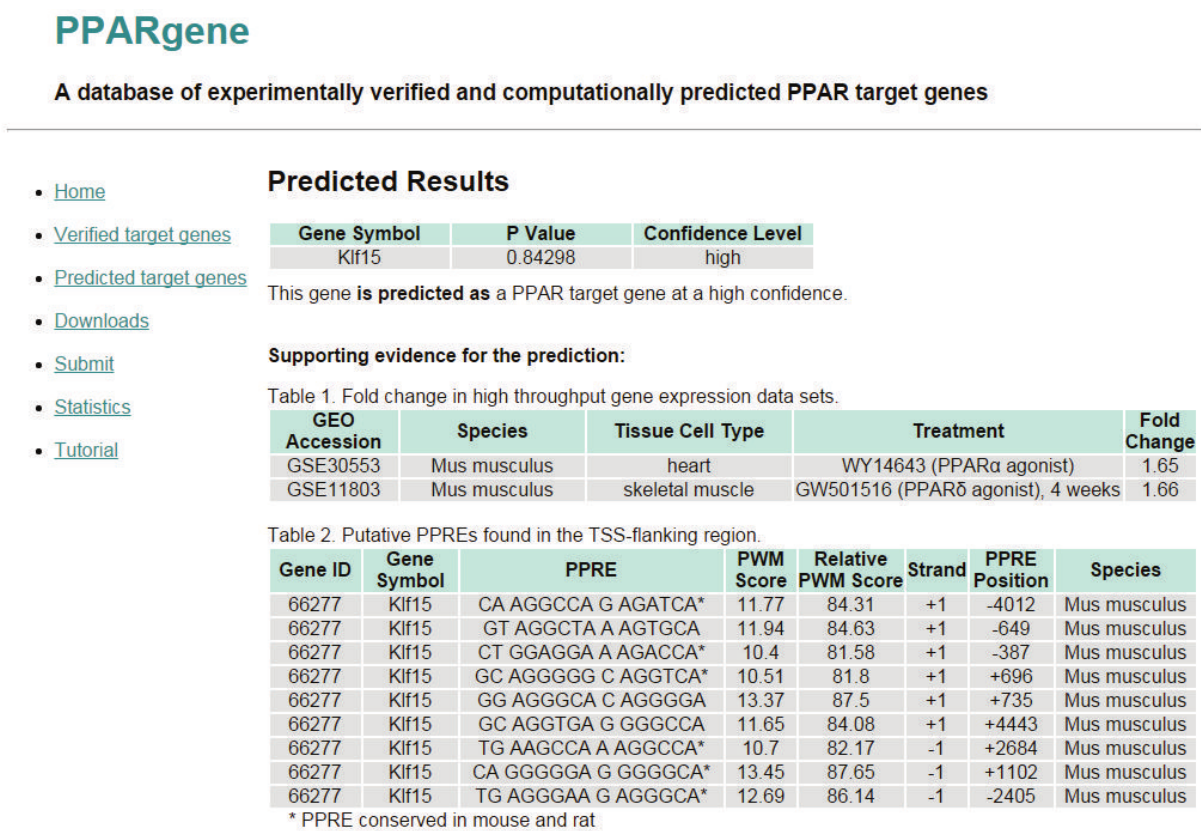
Figure 3: Predicted results of a query gene. High throughput gene expression data and putative PPREs were provided to support the